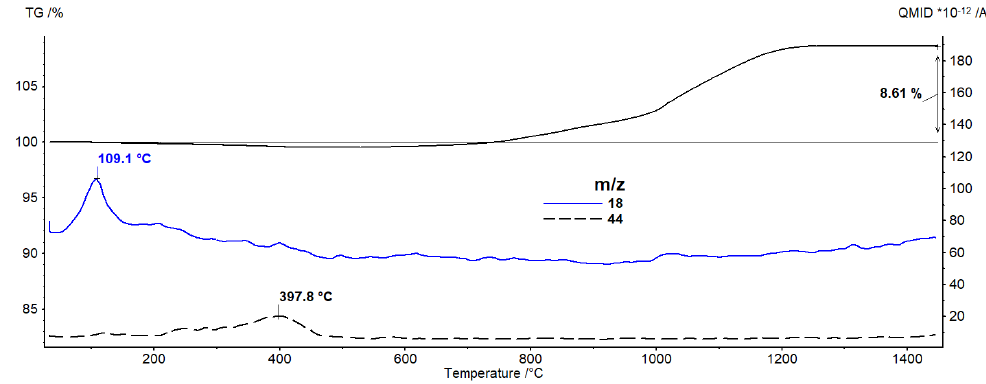
Figure 6. The results of thermal analysis showing changes in the intensity of the m/z value as a function of temperature for the Al 2 O 3 /Ti sample.